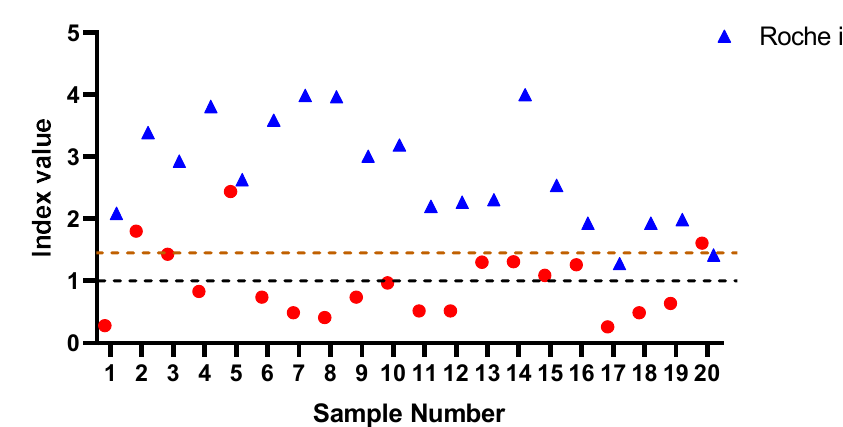
Figure 3. Roche-reported low-level positive samples analysed by Abbott. Statistically significant difference in reported outcomes observed in low-level positive samples analysed by Abbott. All discordant outcomes (n = 16) reported by Abbott were below the manufacturer’s set threshold (brown dashed line) and comprised index values of 0.26–1.31, consistent with PHU Abbott versus TBS discordant range. Black dashed line = Roche manufacturer threshold. Brown dashed line = Ab- bott manufacture